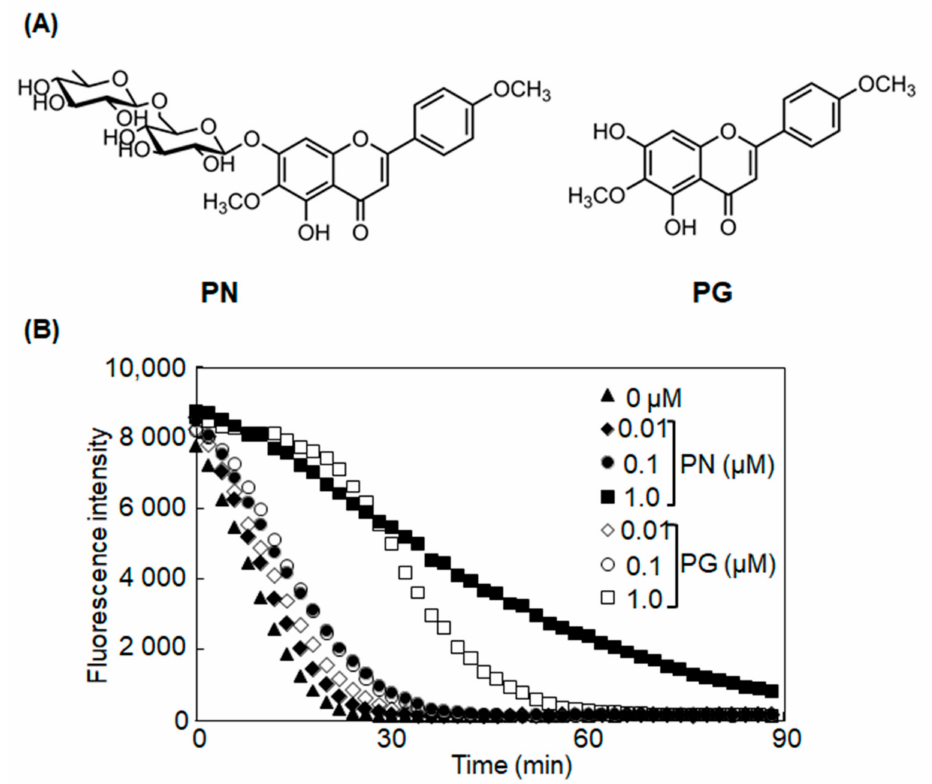
Figure 1. Reactive oxygen species (ROS) scavenging activity of Pectolinarin (PN) and Pectolinarigenin (PG) under cell-free conditions. ( A ) Molecular structures of PN and PG. ( B ) Fluorescence decay curve for antioxidant activity under cell-free